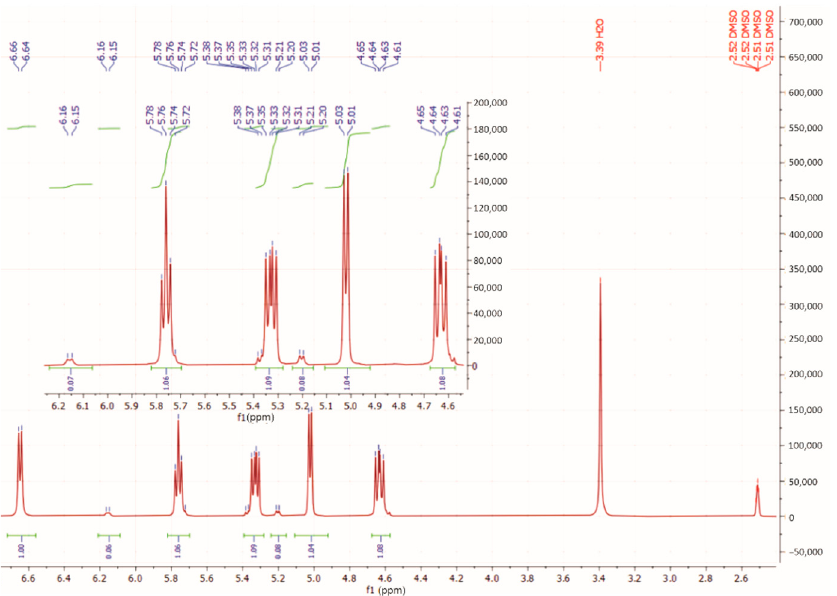
Figure 2. 1 H spectrum for 4,5-dihydroxy-1,3-bis(hydroxymethyl)imidazolidine-2-thione 6 . The spectrum features the signals of various shapes. The doublets correspond to protons of hydroxyl groups bonded with the imidazolidine-2-thione ring, as well as the protons of the methine group based on the structure of compound 6 . Thus, the doublet downfield signal with δ 6.65 ppm most likely is referred to the hydroxyl group and the doublet at 5.02 ppm corresponds to the protons of the methine groups. The ratio of the integral intensities is 1:1. Two signals in the form of a doublet of doublets at 5.38–5.20 ppm and 4.65–4.62 ppm correspond to methylene groups with a ratio of integrated intensities of